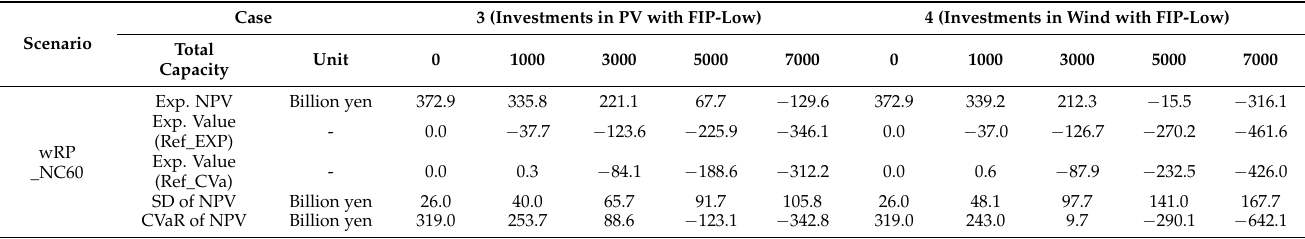
Table A3. Calculation results of Cases 3 and 4 (corresponding to Figure